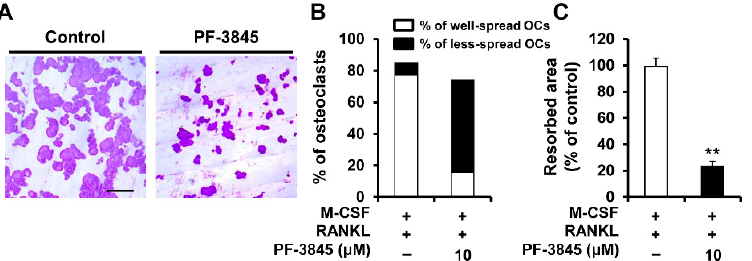
Figure 3. The effect of PF-3845 on the formation of resorption pits. BMMs were grown on bone slices in an osteoclastogenic medium for three days and then the vehicle or 10 µ M PF-3845 was added. ( A ) After 24 h, the bone slices were stained with hematoxylin to examine the resorbed areas. Quantification of the percentage of ( B ) well-spread or less-spread osteoclasts and ( C ) resorption area. Scale bar, 100 μ m. ** p < 0.01 (two-tailed Student’s t -test).